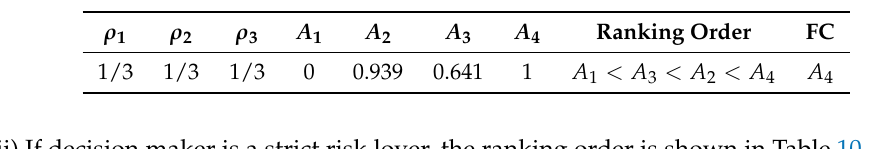
Table 9. Risk neutral.